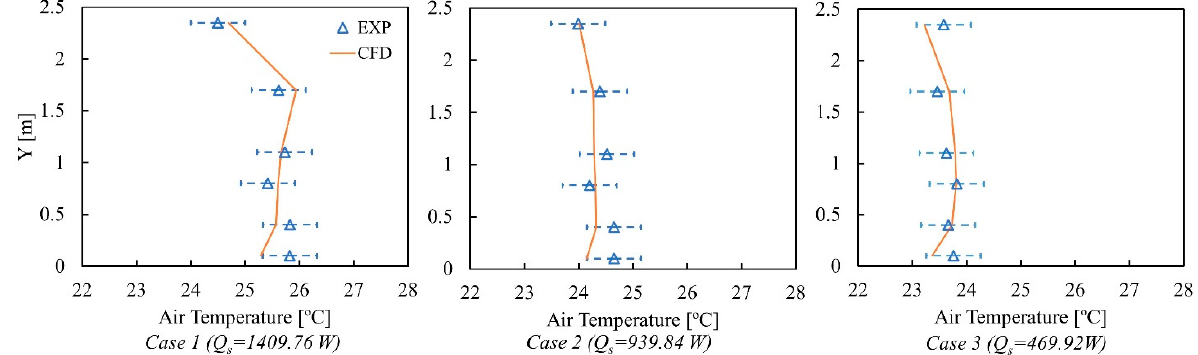
Figure 4. Comparison between CFD and experimental results reported by Shin et al. [27].